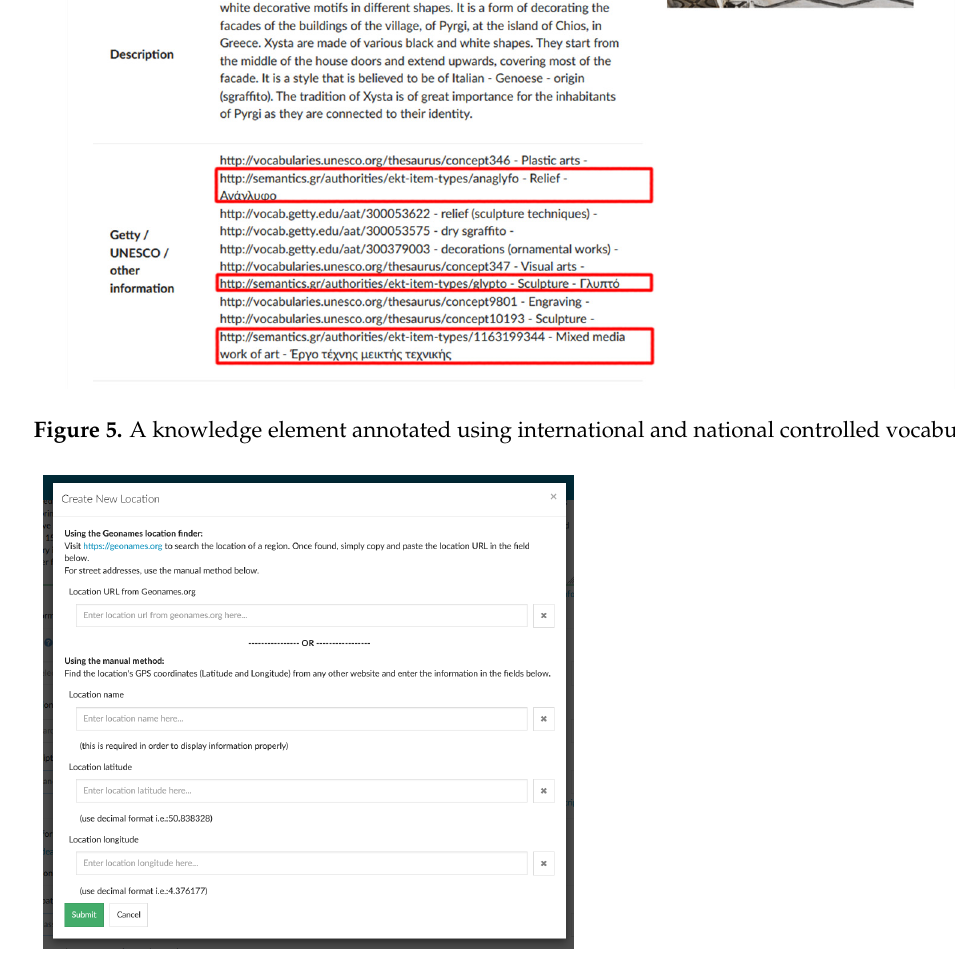
Figure 5. A knowledge element annotated using international and national controlled vocabularies.